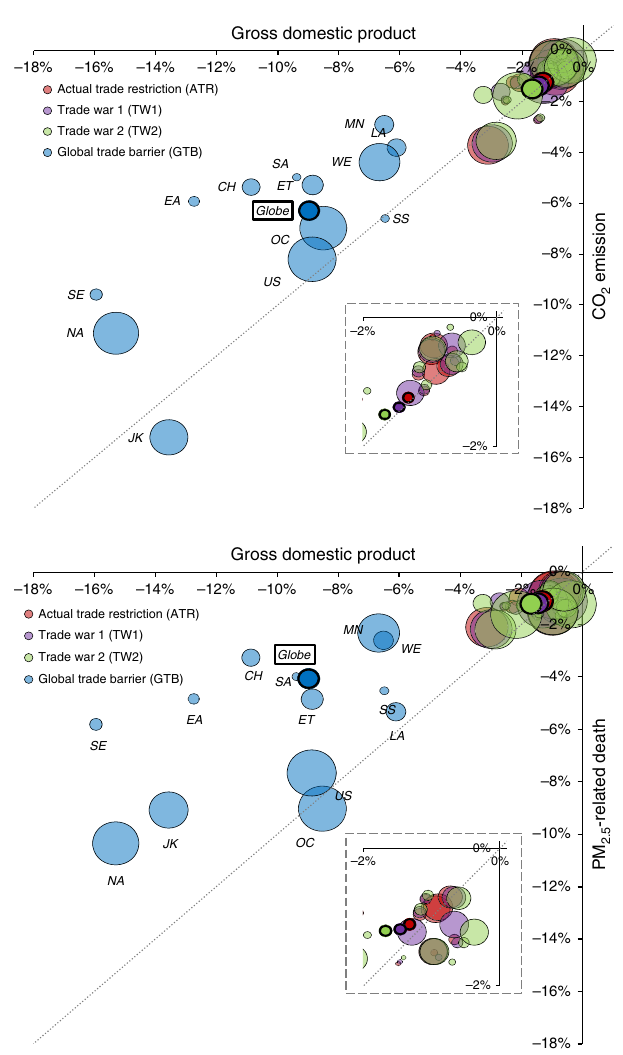
Fig. 2 Contrasting changes in economic performance and environmental quality. The Figures show the relative changes in regional CO 2 emission and PM 2.5 related premature mortality from global free trade scenario (GFT) to each alternative scenario, as a function of respective changes in regional GDP. The color of the dots denotes individual trade scenarios, and the size of the dots denotes the magnitude of regions ’ per capita GDP. The dots with darker colors and thicker borders denote the global values. The inserted Figures in dotted boxes are zoom-in ones to indicate ART, TW1, and TW2. Results here only include scenario-dependent sources. Regions include China (CH), rest of East Asia (EA), Economies in Transition (ET), Japan and Korea (JK), Latin America and Caribbean (LA), Middle East and North Africa (MN), rest of North America (NA), Oceania (OC), South Asia (SA), South-East Asia and Paci fi c (SE), Sub-Saharan Africa (SS), the United States (US), and Western Europe